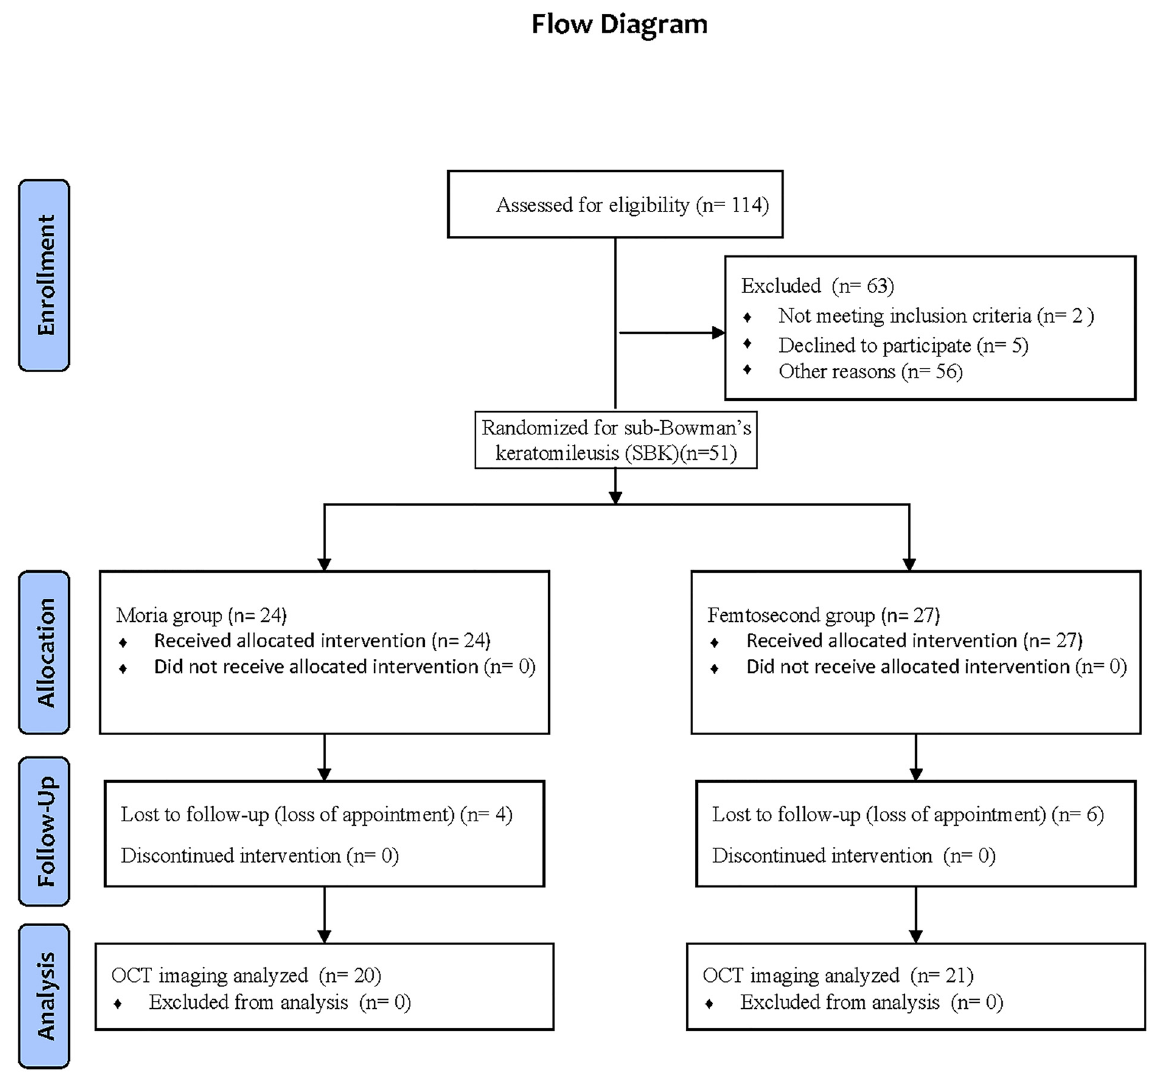
Fig 1. CONSORT flow diagram of OCT imaging observations on flap creation methods for sub-Bowman 0 s keratomileusis